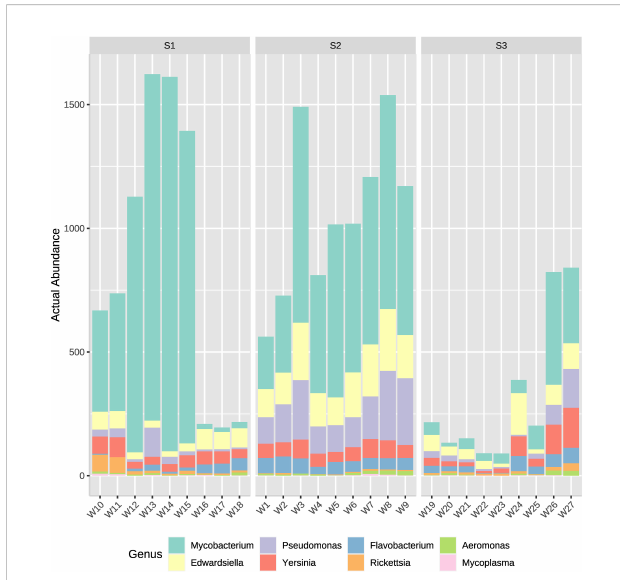
FIGURE 7 Actual abundances of ASVs corresponding to several potentially